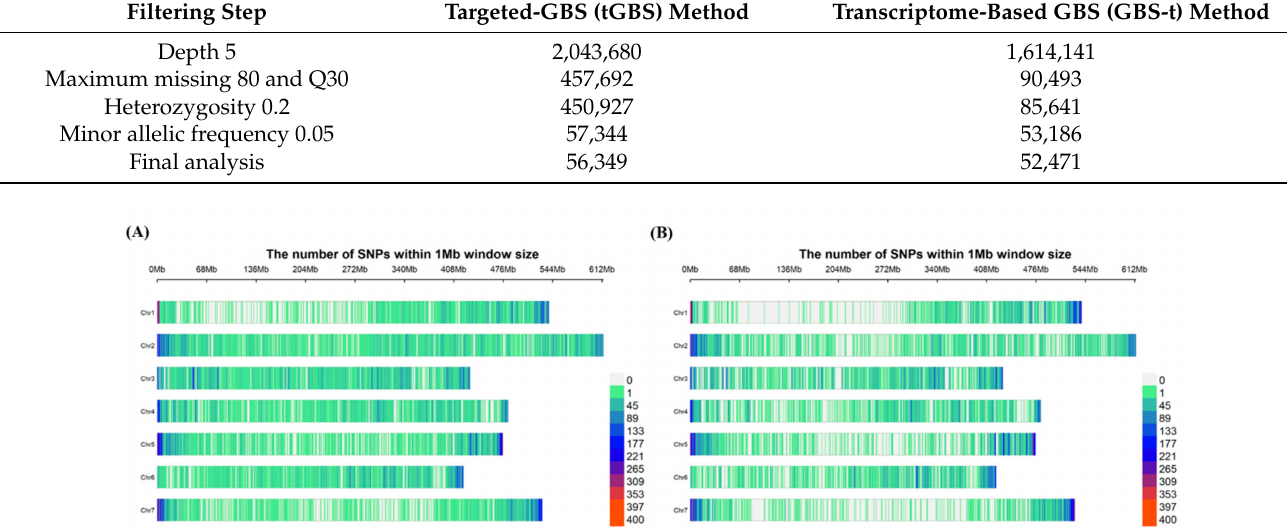
Table 1. Number of SNPs remaining after each filtering step.